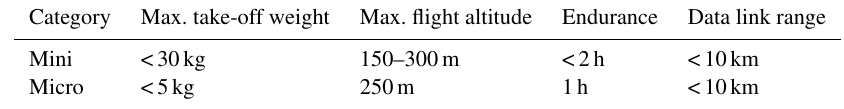
Table 1. Classification of mini and micro UAV systems, according to UVS International (UVS International, 2018).